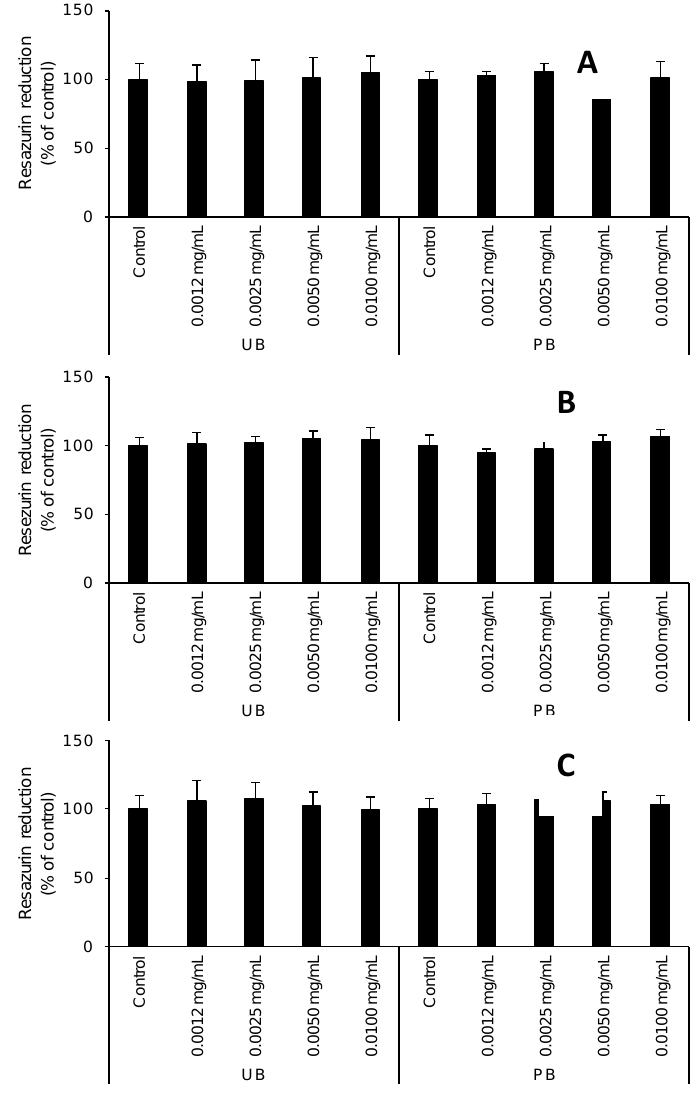
Figure 1. Effect of increasing concentrations (0.0012, 0.0025, 0.0050, and 0.0100 mg) of extracts from the PB (packed string bean) and UB (unpacked string bean) on resazurin reduction in SCC-15 cells after 24 ( A ), 48 ( B ), and 72 h ( C ). The data are expressed as the means ± SEM of four independent experiments, each of which consisted of eight replicates per treatment group. The samples did not show statistically significant differences.